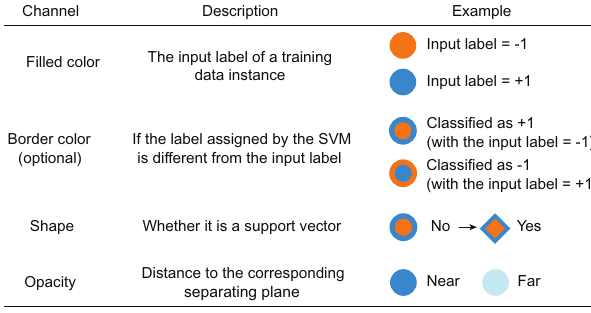
Fig. 5 Our visual encoding